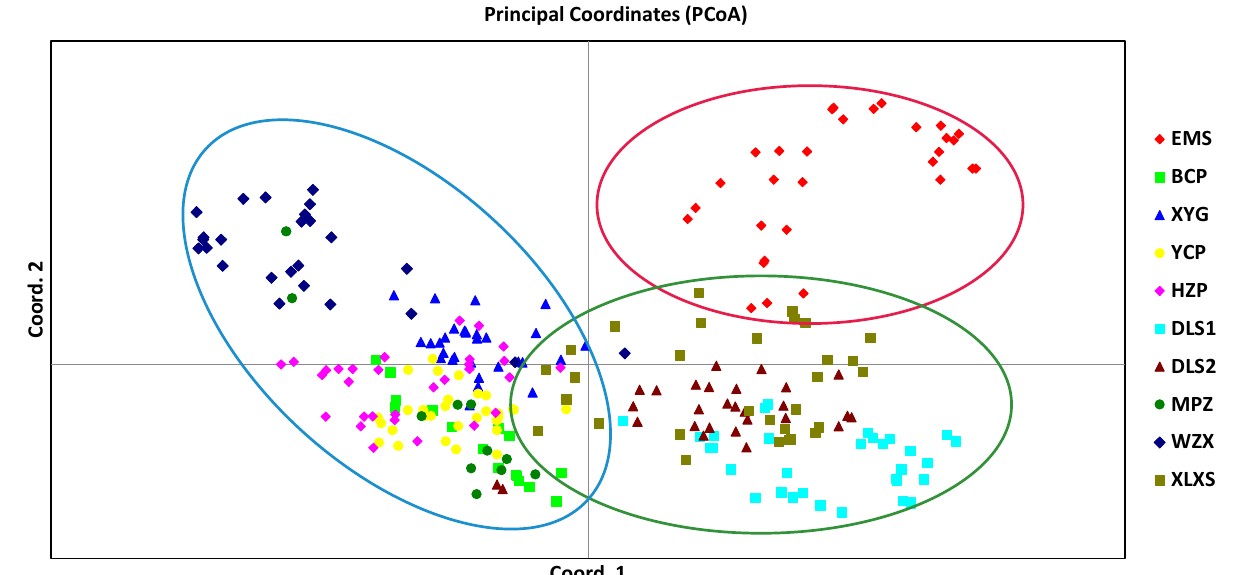
Figure 3. Principal coordinate analysis (PCoA) of all individuals from ten O. serrulatus populations.